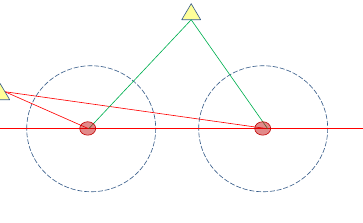
Figure 5.a. Rotate 360°at 2 different points. Optical parallaxes are different for different direction.